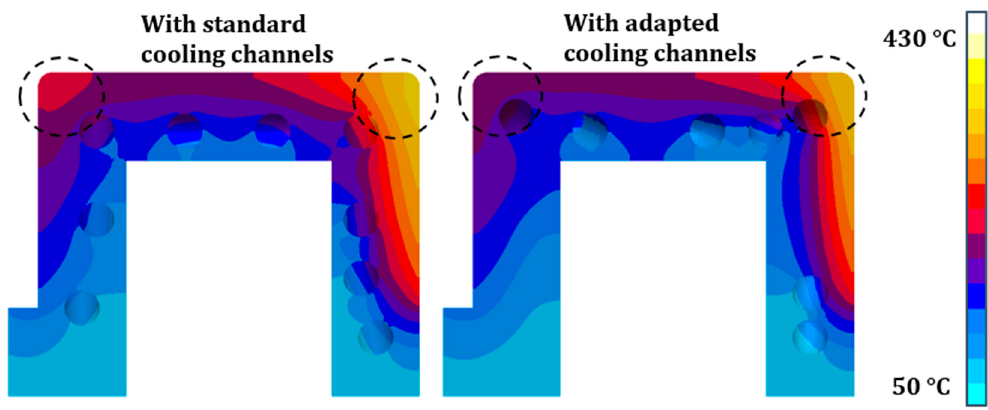
Figure 10. The temperature distribution in the middle plane of the core module after 54 s of solidification when 80% of the material has solidified.